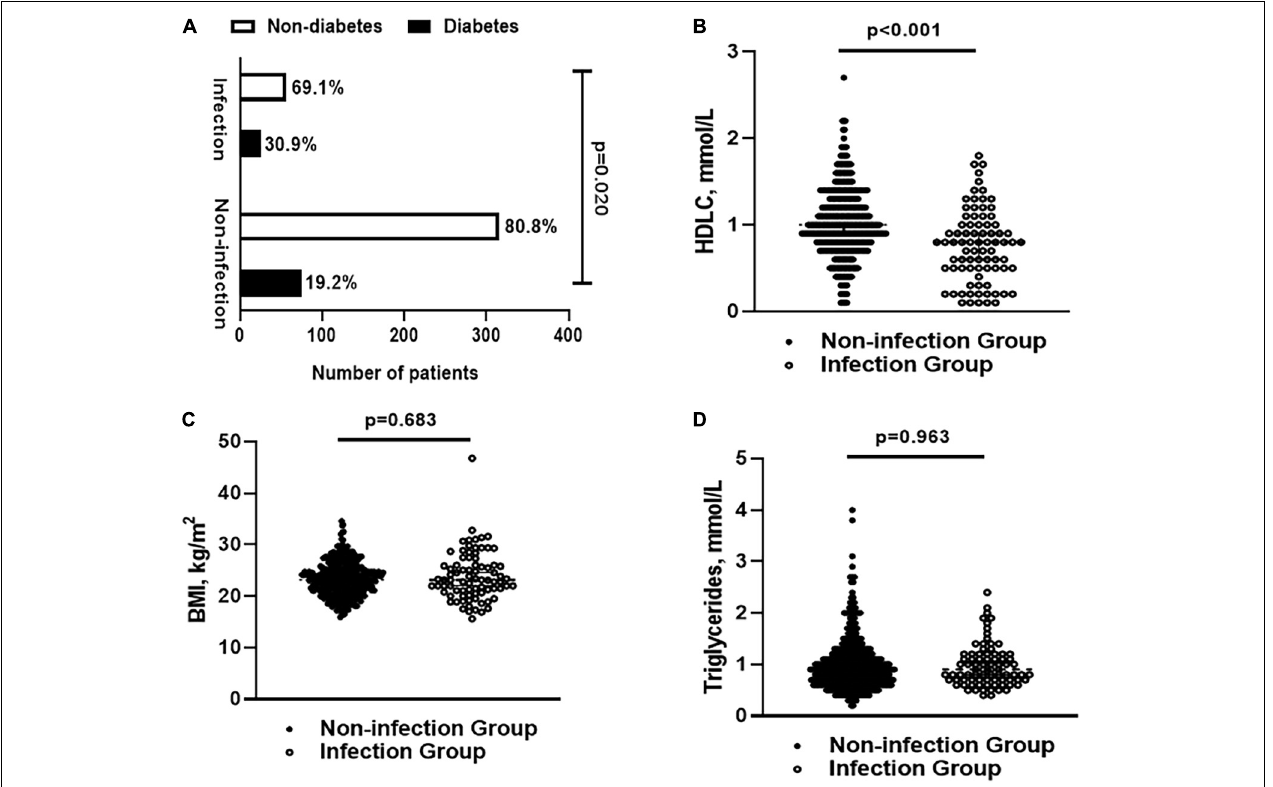
FIGURE 2 | (A) The percentage of patients with diabetes and non-diabetes in infection and non-infection groups; (B) levels of HLDC in infection and non-infection groups; (C) BMI in infection and non-infection groups; and (D) levels of triglyceride in infection and non-infection groups. BMI, body mass index; HDLC, high-density lipoprotein